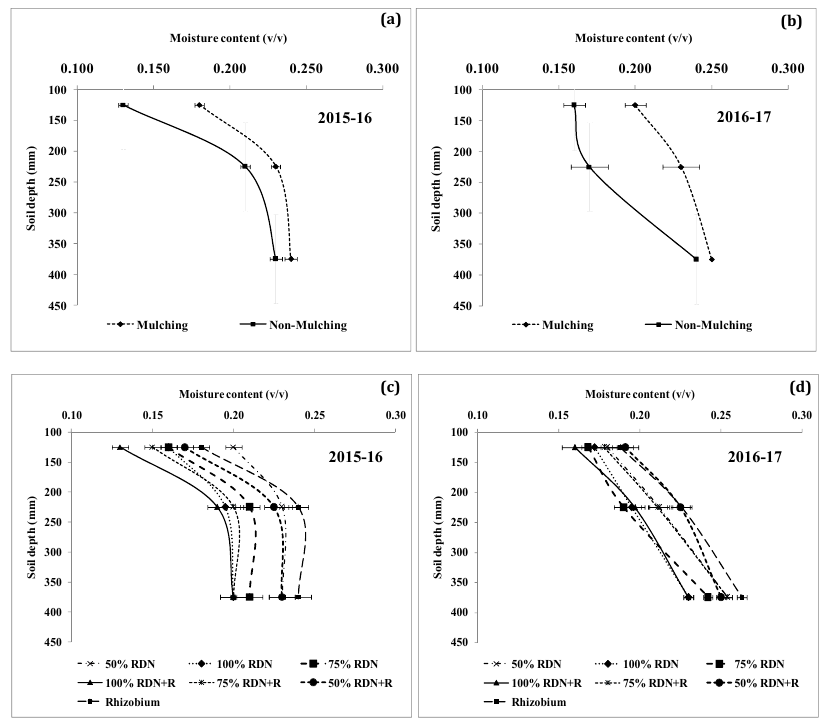
Figure 6. Effect of mulch ( a , b ) and nutrient dose ( c , d ) on soil moisture content ( v / v ) at pod formation of peanut (data from 2015–2016 and 2016–2017 crop seasons, respectively); error bars represent the least significant difference value.